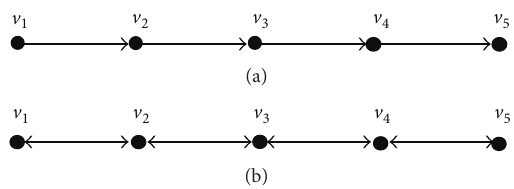
Figure 4: Two directed fuzzy social